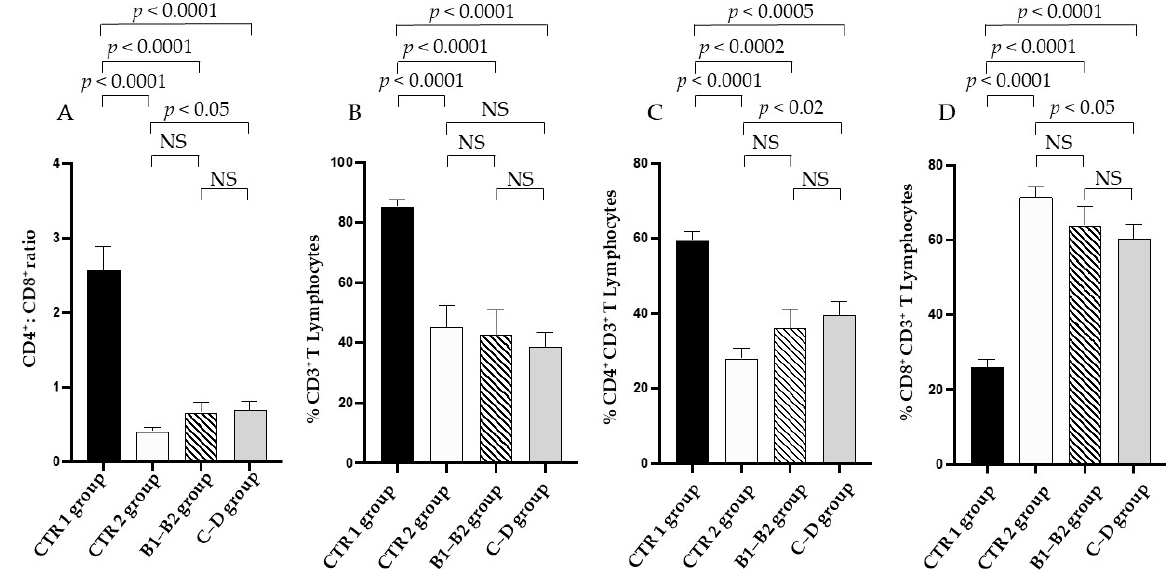
Figure 3. The immune profile of enrolled dogs. CD4:CD8 ratio ( A ), CD3 + T ( B ), CD4 + CD3 + ( C ), and CD8 + CD3 + ( D ) lymphocytes in the healthy young (CTR 1) group (black column), the healthy elderly (CTR 2) group (white column), the mild and moderate MMVD (B1–B2) group (dashed column), and the severe and very serious MMVD (C–D) group (grey column). A Mann–Whitney matched-pairs signed-rank test was performed to compare the different groups. NS means “no significant